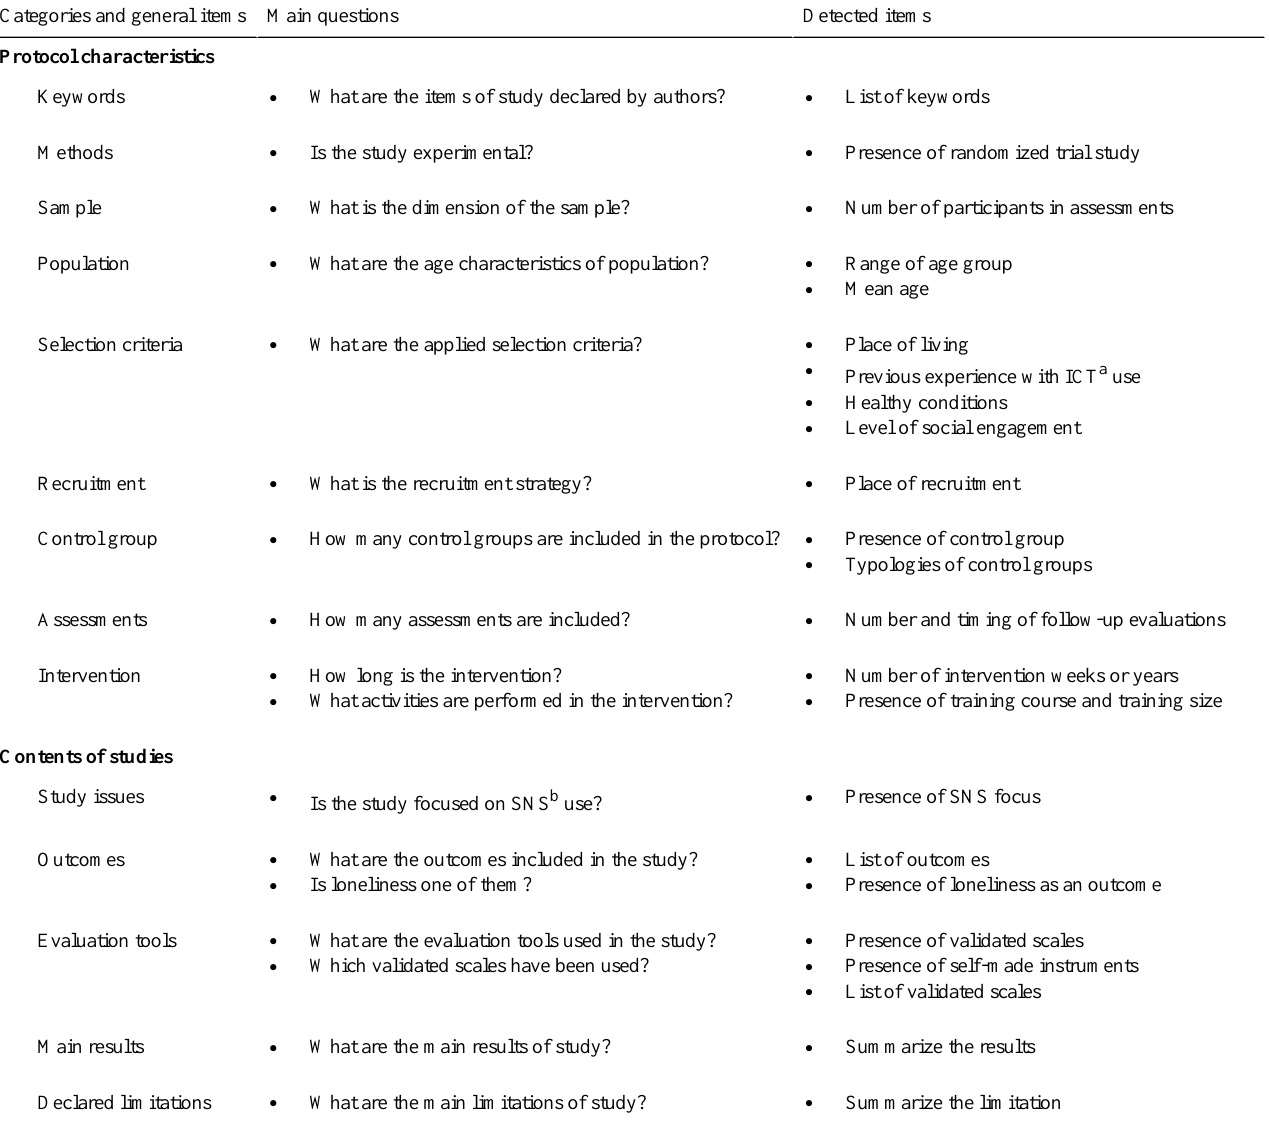
Table 1. Frameworks of analysis: general items, main questions, and detected items by analysis macro